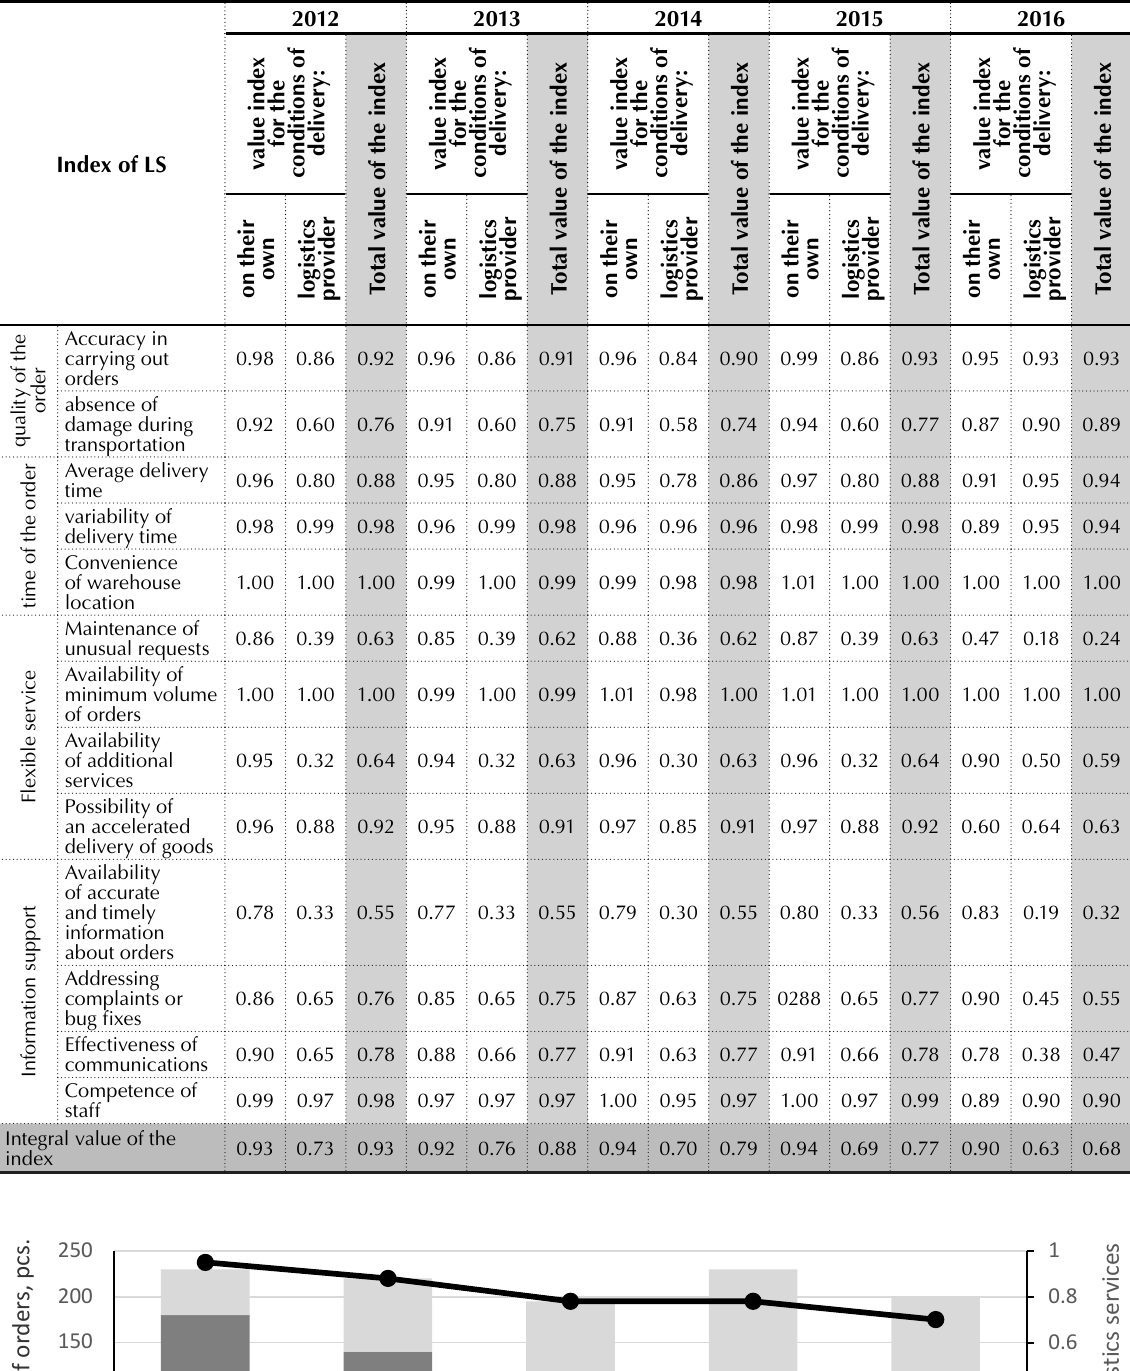
Table 1. Indexes of logistic service of Sumy Engineering Works Ltd. in 2012–2016